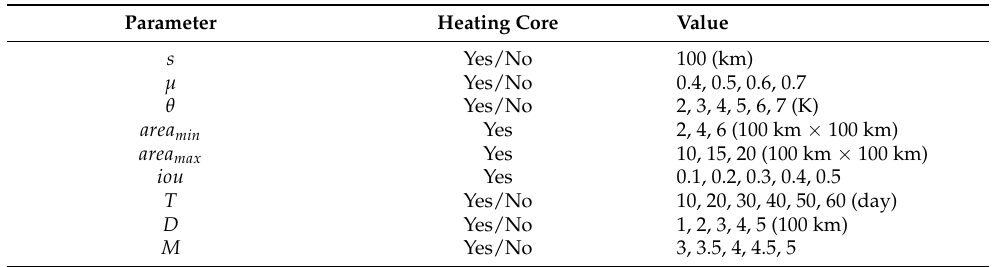
Table 5. Candidate parameters for models with and without a “heating core” when the moving window scale is 100.